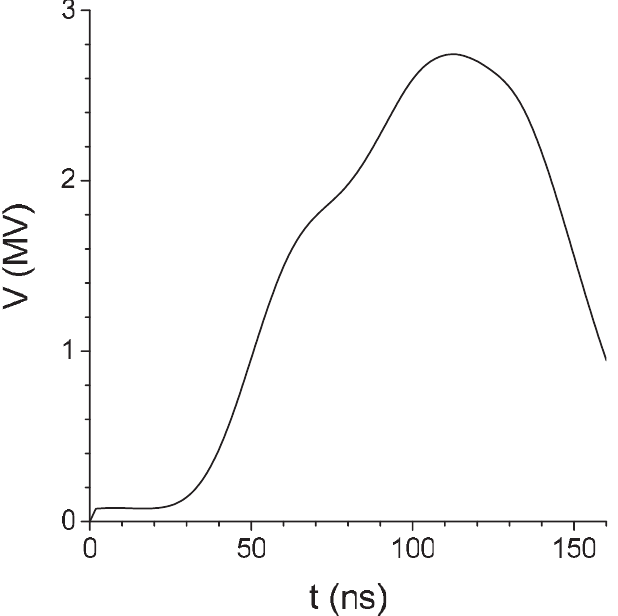
FIG. 9. Forward-going voltage waveform used to drive the transmission-line